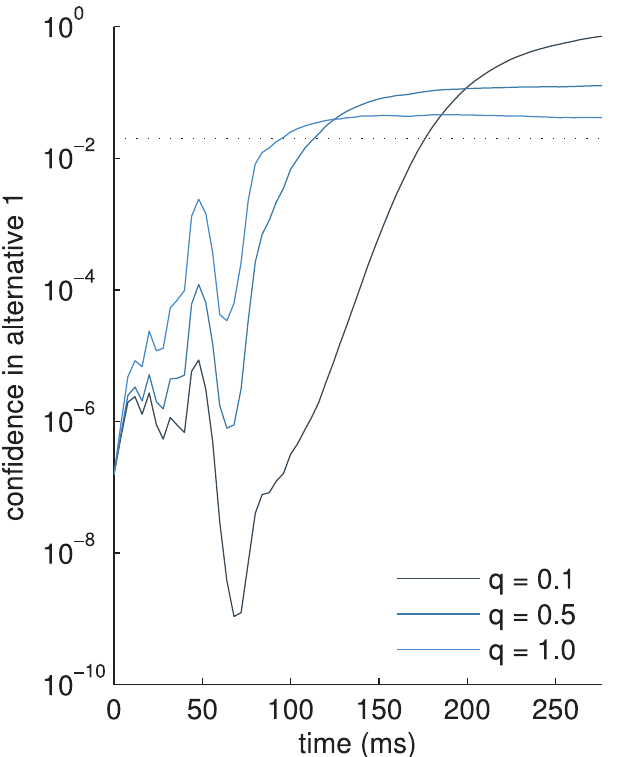
Fig 4. Example trial showing evolution of confidence in alternative 1, p (z t = ϕ 1 j X Δ t : t ) (notice log-scale and initial, very low values), for different values of dynamics uncertainty q . Larger values of q mean that only smaller confidence values can be reached even after the decision state z t eventually settled into the stable fixed point ϕ 1 (compare, e.g., confidence for q = 1 and q = 0.5 at 200ms, note log-scale). Horizontal dotted line: confidence value used as bound ( λ =